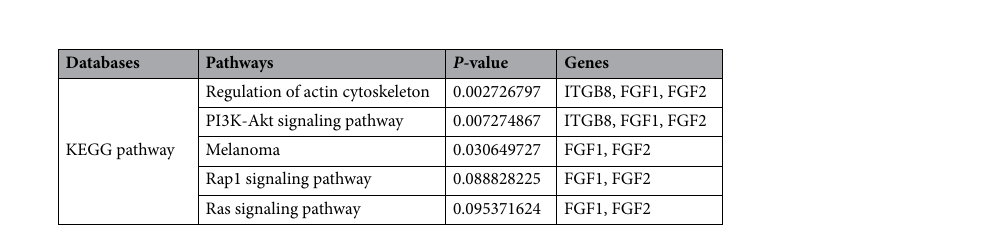
Table 3. KEGG enrichment analysis of common